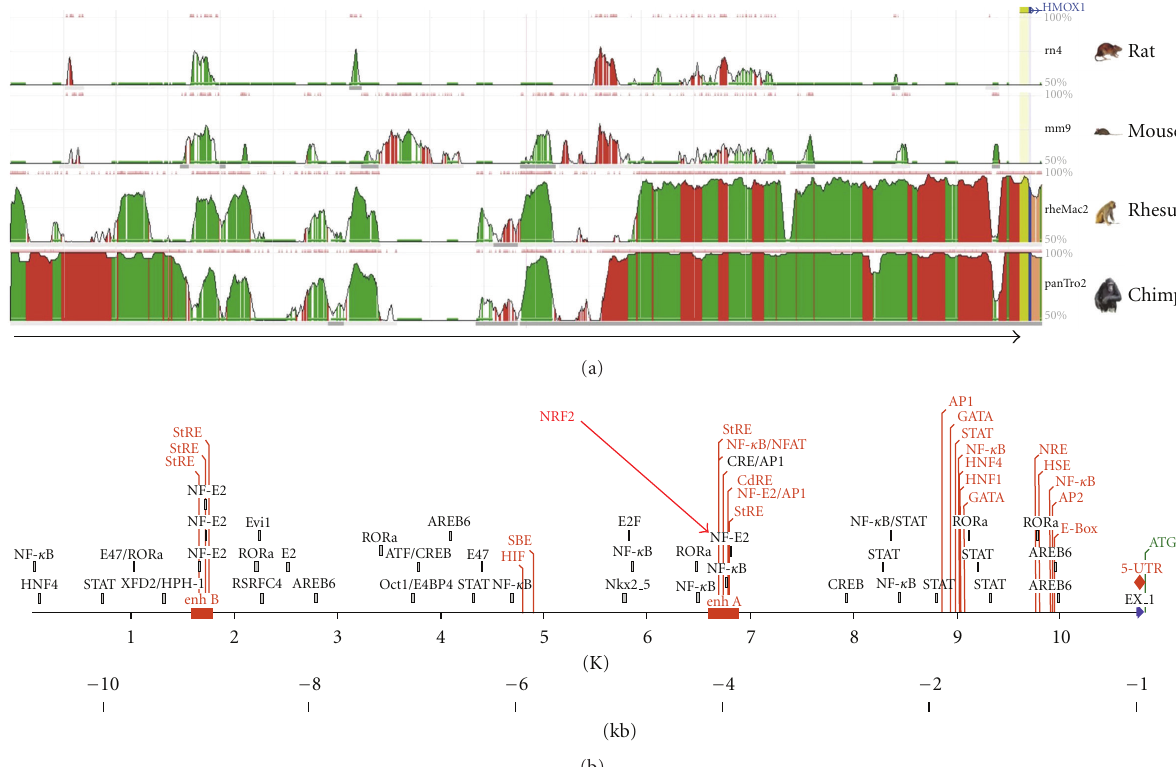
Figure 4: Comparison of the HO-1 promoter sequences of di ff erent species. (a) Comparison of the 5 (cid:3) -flanking sequences (10kb) of the rat, mouse, rhesus macaque, chimpanzee, and human (arrow) HO-1 gene using the ECR-Browser software (http://ecrbrowser.dcode.org/). The search area was 10bp, and the minimal homology was 80%. The height of the curves (50% < X < 100%) indicates the homology (red: intergenic regions, green: single repeats, yellow: untranslated regions of the RNA (UTR), blue: exon, salmon: intron, pink ECR, above). (b) Map of transcription factor binding sites (TFBS) in the human HO-1 promoter. TFBS labeled in red have been verified experimentally in di ff erent cells systems (see also [33]).